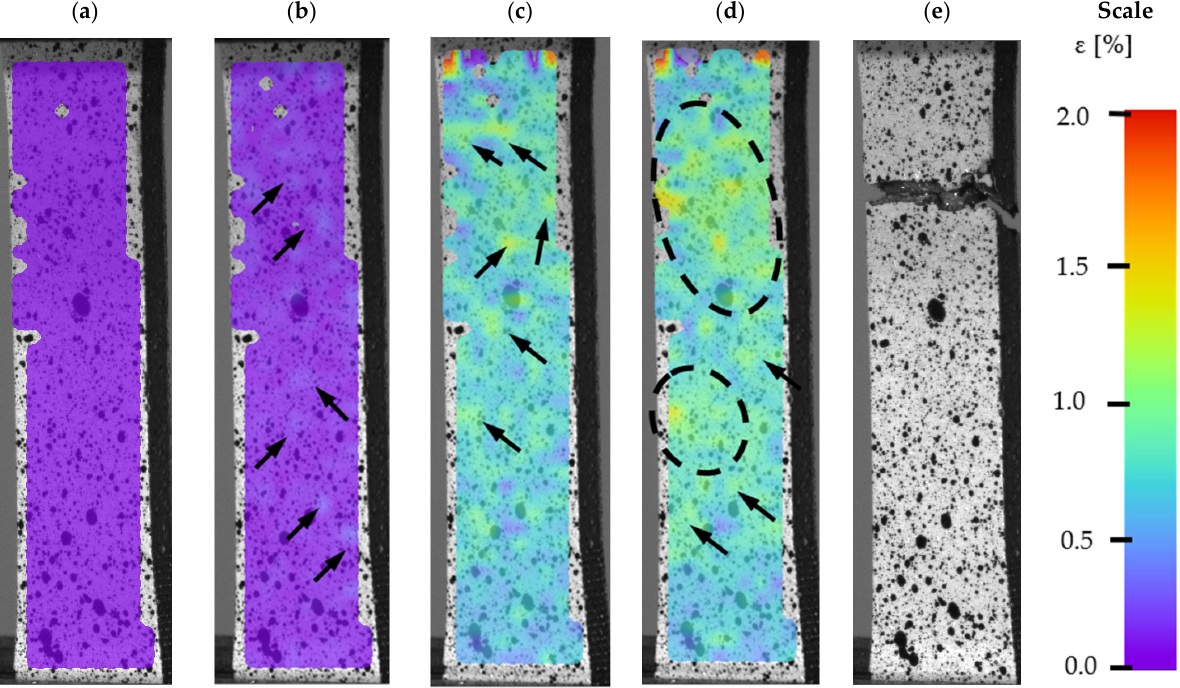
Figure 11. DIC of M300 steel in AHT condition during tensile testing, ( a ) a reference sample before the tensile testing, ( b ) Rp 0.2% proof strength, ( c ) the ultimate tensile strength (UTS) point, ( d ) breaking point, and ( e ) a sample after a fracture.